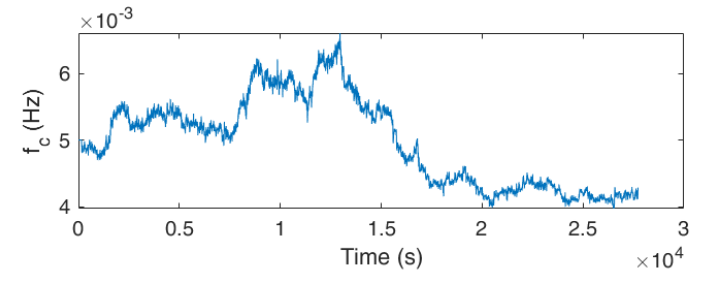
Figure 4. Phase II: Adapt the cutoff frequency f c with an initial cutoff frequency given.